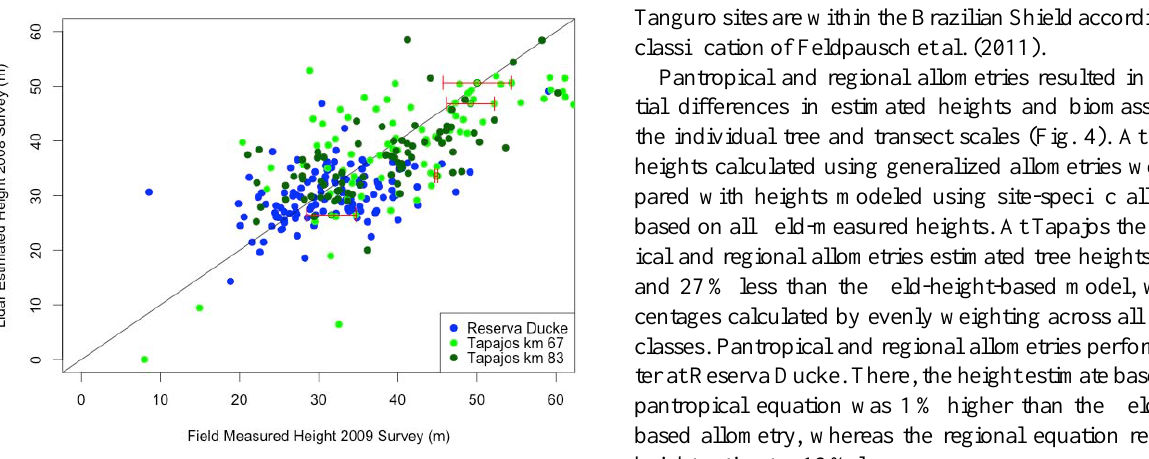
Fig. 3. Comparison of field-measured height to that estimated us- ing the lidar canopy height model (CHM) for stems with emergent crowns at Reserva Ducke and Tapajos sites (Tapajos km 67 and Tapajos km 83). RMSE of emergent crowns is 7.3m. Where mul- tiple field heights were taken for emergent stems, mean values are shown with error bar showing the range of repeated